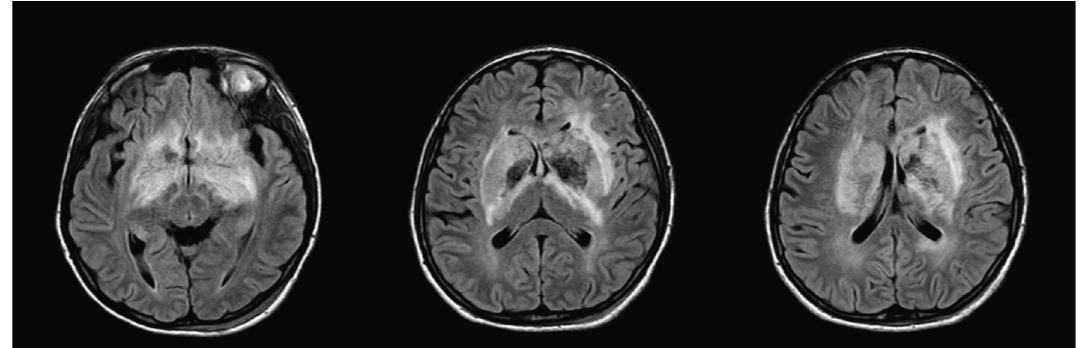
Figure 3: T2-FLAIR image, an axial section at basal ganglia.